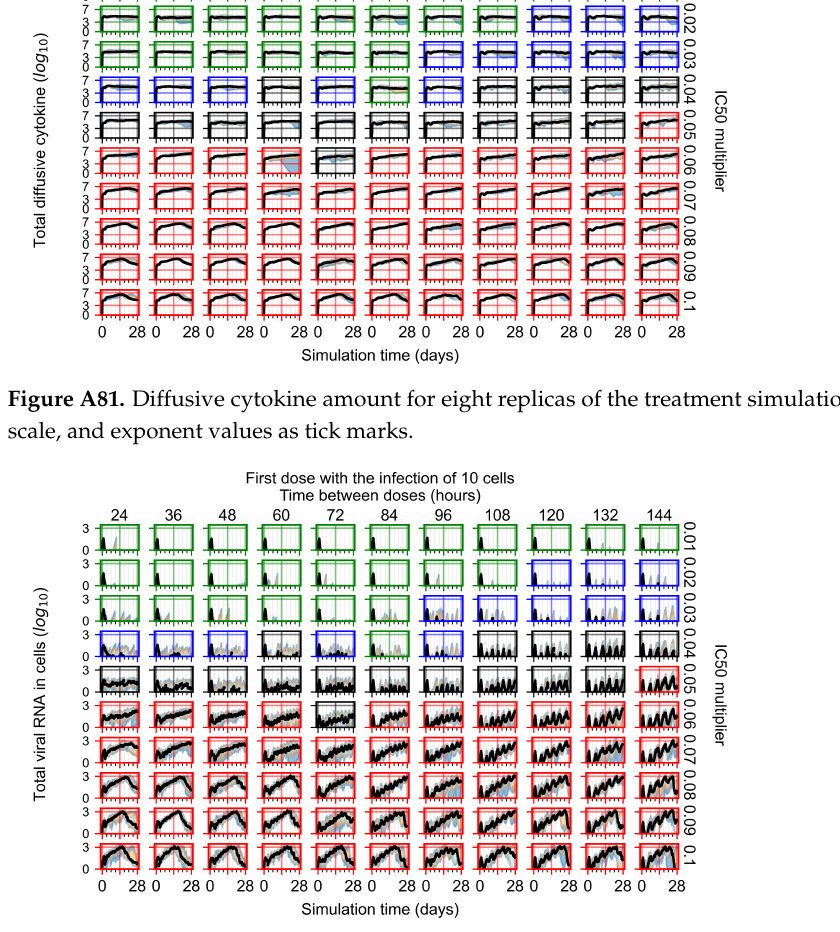
Figure A82. Amount of viral RNA in infected cells (arbitrary units), Y axis in log scale, and exponent values as tick